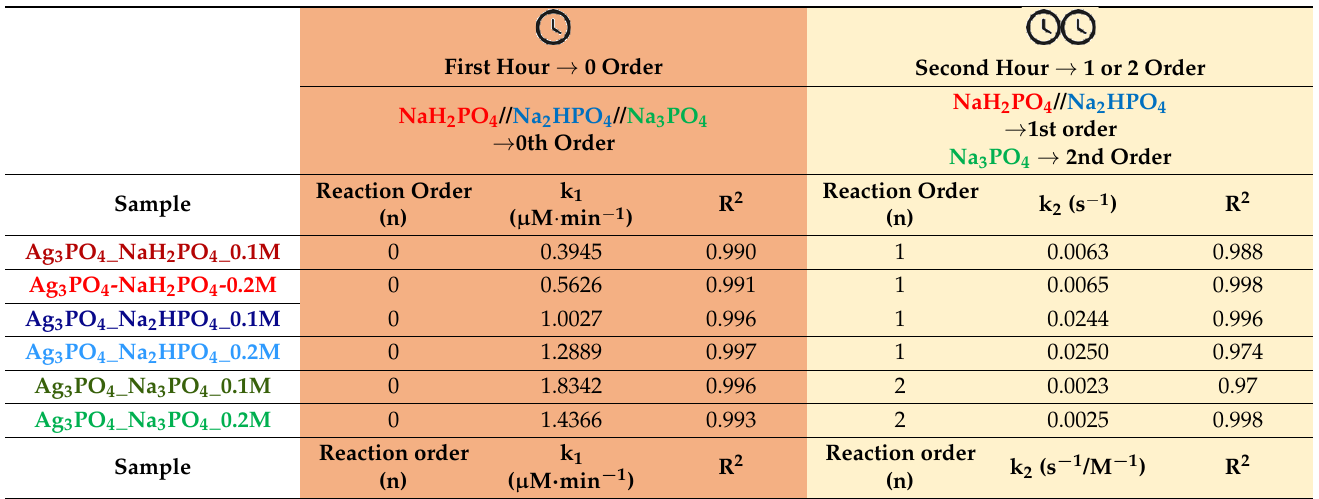
Table 2. Kinetics of methyl orange degradation of the Ag 3 PO 4 samples.